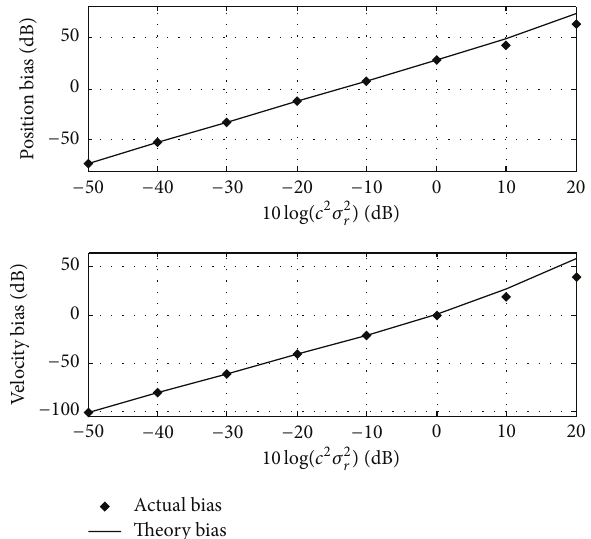
Figure 6: Comparison between theoretical and actual bias of estimation of source position and velocity by MLE for far-field source.